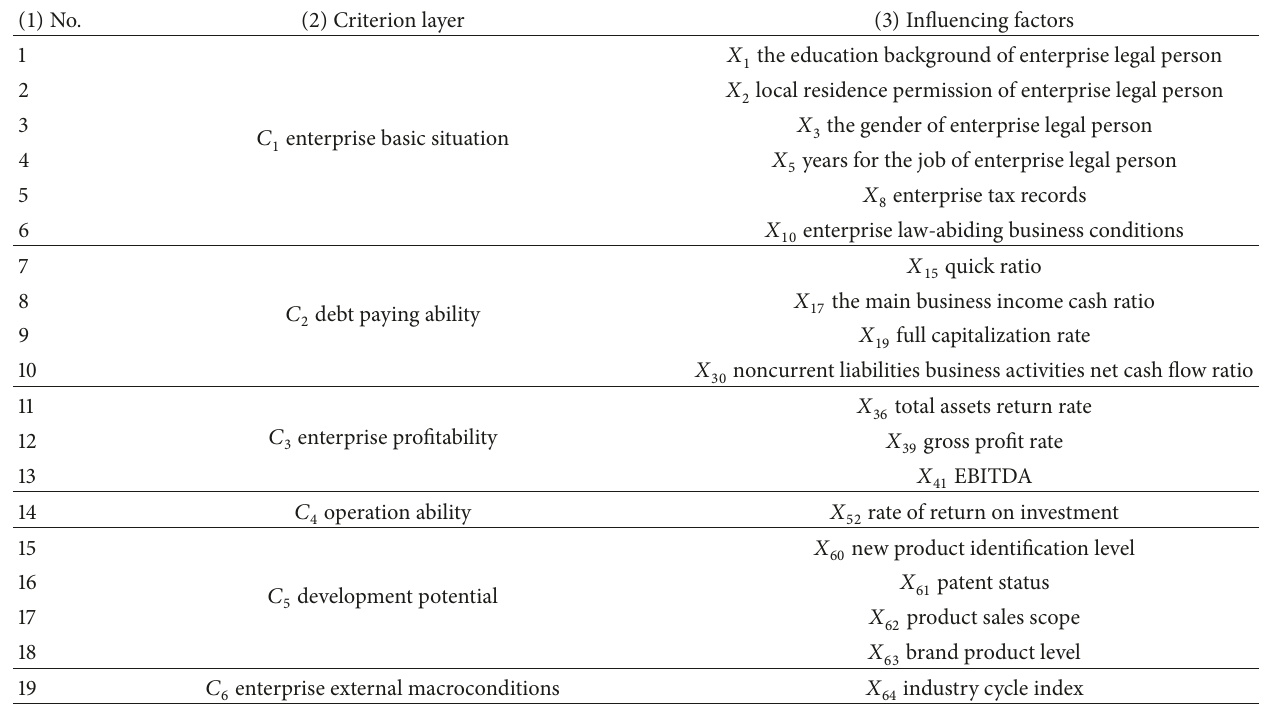
Table 6: The key influencing factors of small enterprise financing